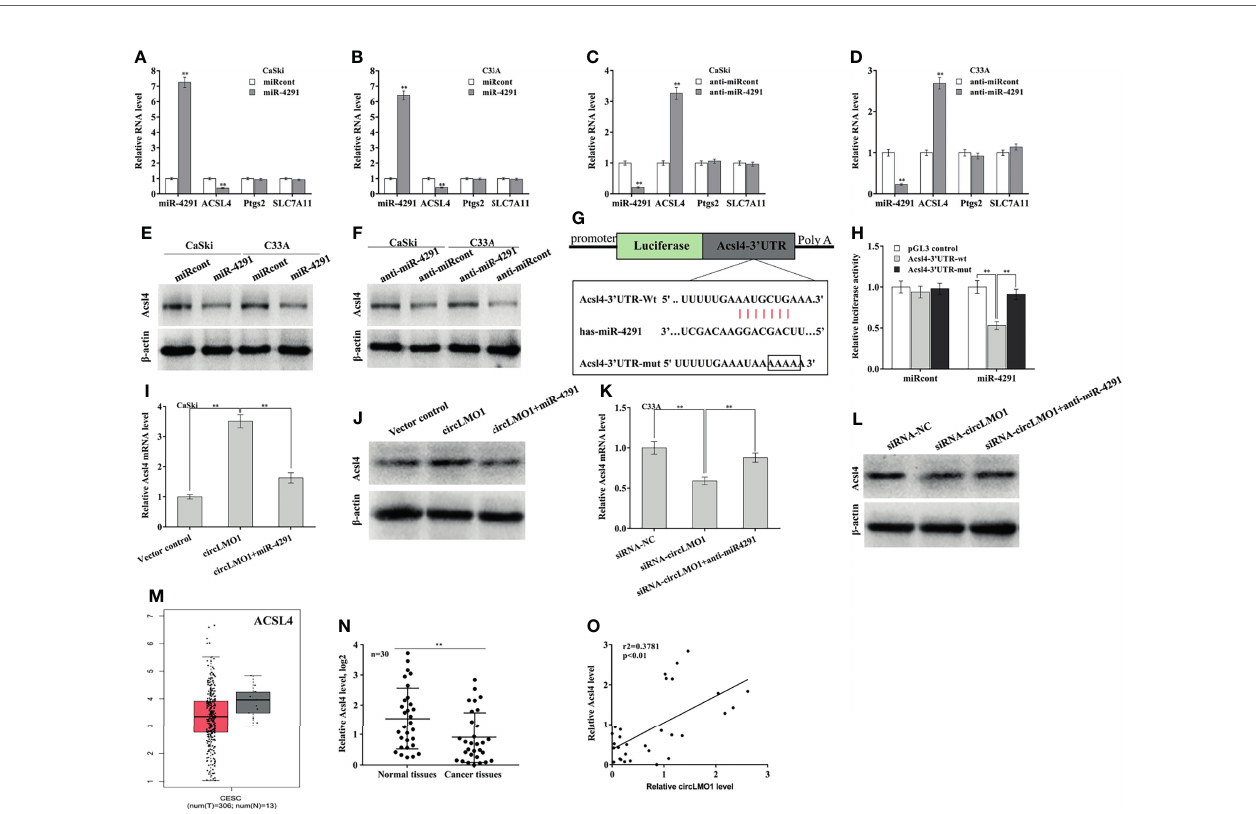
FIGURE 6 | CircLMO1 increases ACSL4 expression by sponging miR-4291. qPCR analysis of Acsl4, Ptgs2, and Slc7a11 level in CaSki (A) and C33A cells (B) after miR-4291 overexpression. qPCR analysis of Acsl4, Ptgs2, and Slc7a11 level in CaSki (C) and C33A cells (D) after miR-4291 inhibition. (E) Western blot analysis of ACSL4 protein level in CaSki and C33A cells after miR-4291 overexpression. (F) Western blot analysis of ACSL4 protein level in CaSki and C33A cells after miR- 4291 inhibition. (G) Schematic illustration of the predicted miR-4291-ACSL4 interactions. (H) Luciferase activities were assessed in C33A cells after co-transfection with miR-4291 and Acsl4-3 ’ UTR-wt luciferase reporters (or its mutant). qPCR (I) and western blot analysis (J) of Acsl4 expression in CaSki cells after circLMO1 overexpression in the presence or absence of miR-4291 mimics. qPCR (K) and Western blot analysis (L) of Acsl4 expression in C33A cells after circLMO1 knockdown in the presence or absence of miR-4291 inhibitor. (M) Acsl4 levels in cervical squamous cell carcinoma and endocervical adenocarcinoma were analysed via GEPIA database. (N) qPCR analysis of Acsl4 level in cervical cancer tissues (n = 30) and matched normal tissues. (O) The positive association between the circLMO1 level and the miR-4291 level in 30 cervical cancer tissues. *p < 0.05, **p <